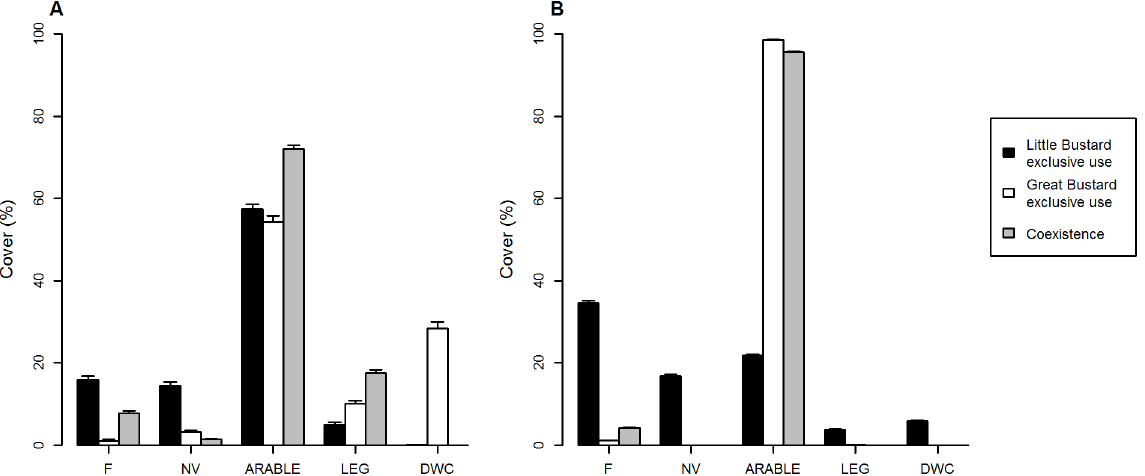
Figure 4. Land use cover in each area type. Mean and standard error of land use cover in the predicted Little and Great Bustard exclusive use and coexistence areas for 2011 in Campo Real (A) and 2008 in Calatrava (B) (F: short term fallows, NV: natural vegetation encompassing long term fallows and low height scrubs; Arable: cereal fields and ploughed lands; LEG: leguminous crops; DWC: dry woody cultures).